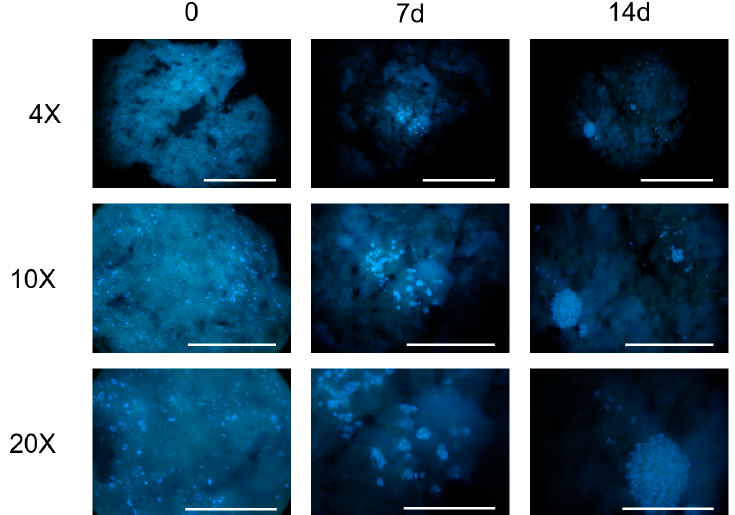
Figure 6. Images from fluorescence microscope (Olympus CX41) at different magnifications (4×, 10×, 20×) of the constructs printed with an initial concentration of 2 × 10 6 UMR-106 cells/mL at different time points. Nuclei stained by Hoechst 33342. Scale bar 1 mm (4×), 500 μ m (10×), 250 μ m (20×).